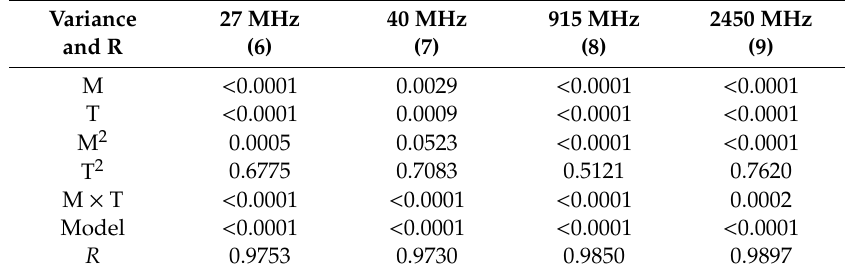
Table 6. Significance of the regressed models in Equations (6)–(9) for the pecan kernel samples at four specific